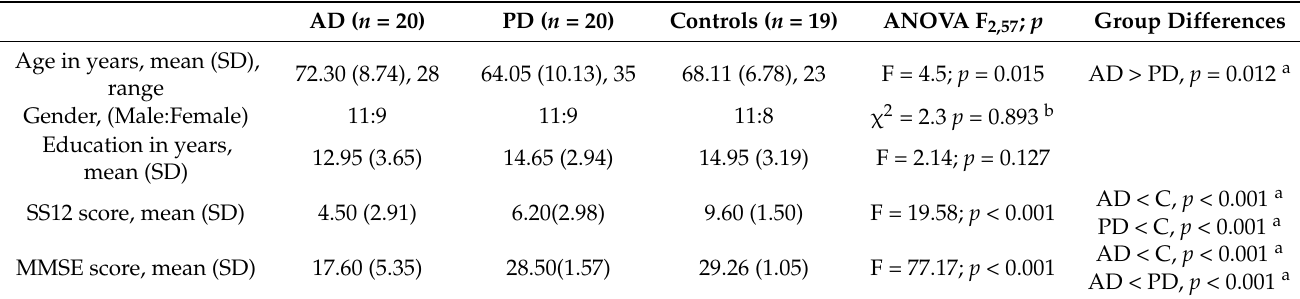
Table 1. Clinical and demographic characteristics.